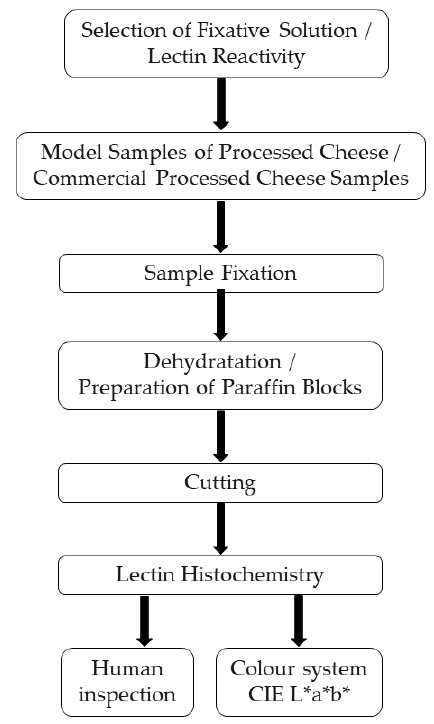
Figure 1. Methodology and analysis scheme.